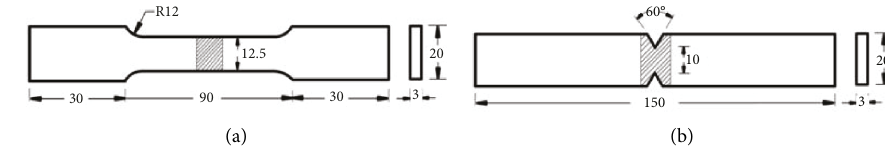
Figure 2: Dimensions of tensile specimen. (a) Unnotched tensile specimen. (b) Notched tensile specimen.